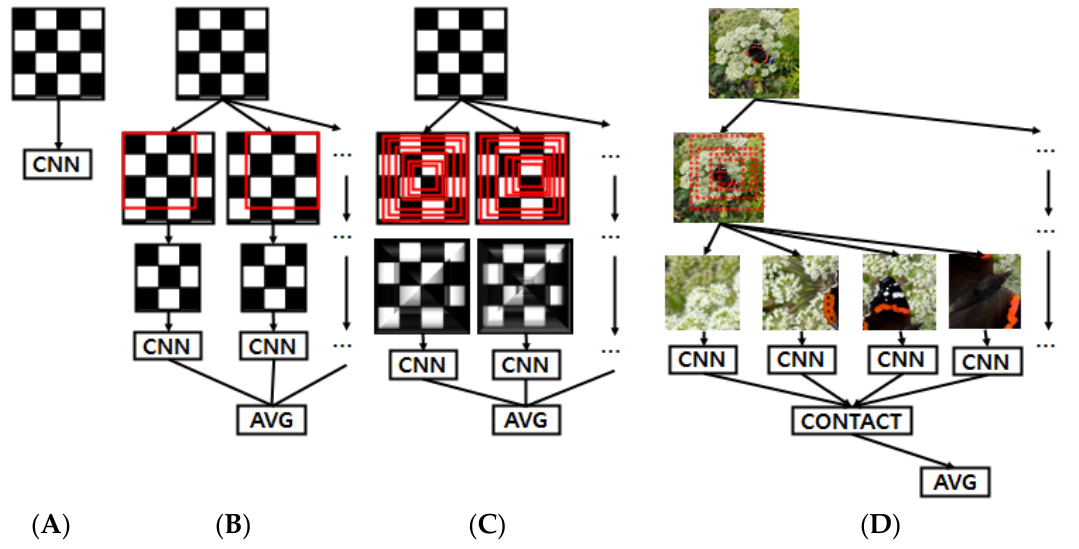
Figure 29. Standard CNN and its fixation models. The ( A ) was the standard CNN, and the ( B ) was coarse fixations, which involves roughly focusing on different regions of the image. The ( C ) was retina fixation to extract nonuniform sampling, and the ( D ) was cortical fixations, where the ResNet architecture is separated into multiple independent branches to process the scales at each eccen- tricity.